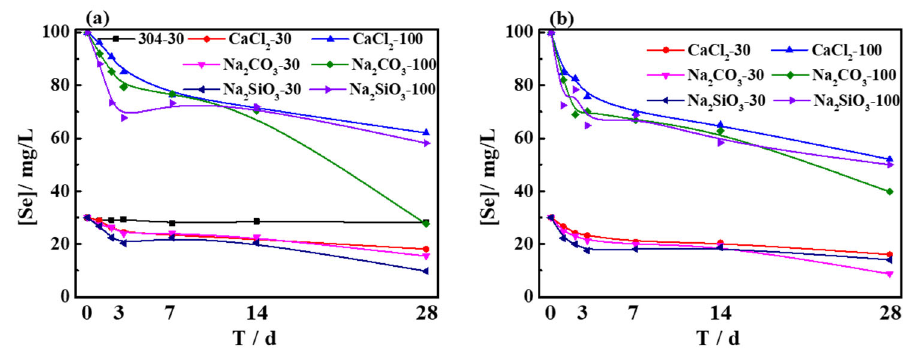
Figure 6. The curve of concentration of dissolved Se plotted against time after treating the 304 stain ‐ less steel by polarization measurements in different solutions: ( a ) SG + Na 2 SeO 3 ; ( b ) SG + Na 2 SeO 4